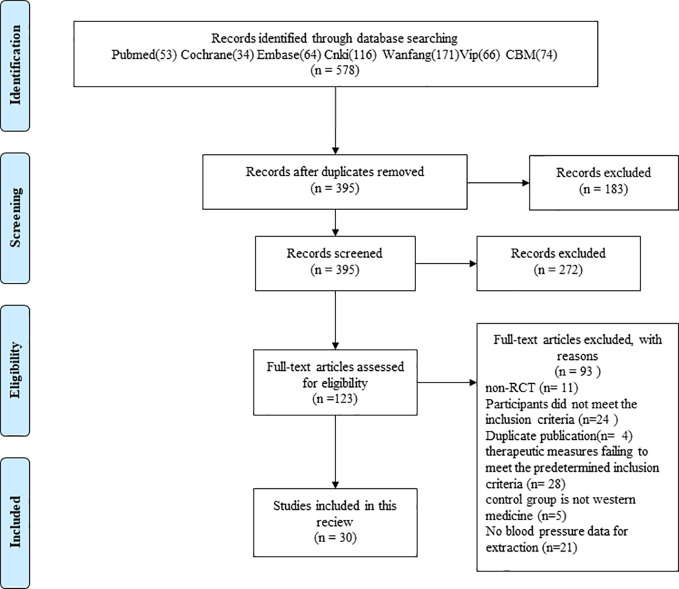
Flow diagram of literature search and study selection.